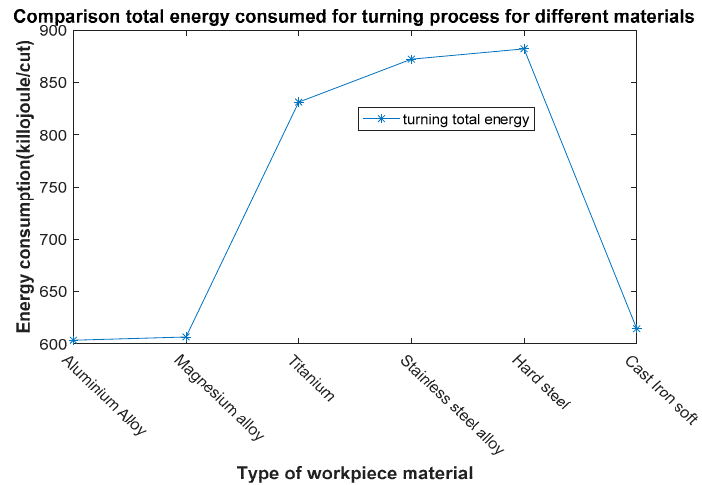
Figure 12. Comparison of total energy consumed for turning processes for different materials. J. Manuf. Mater. Process. 2018 , 2 , x FOR PEER REVIEW